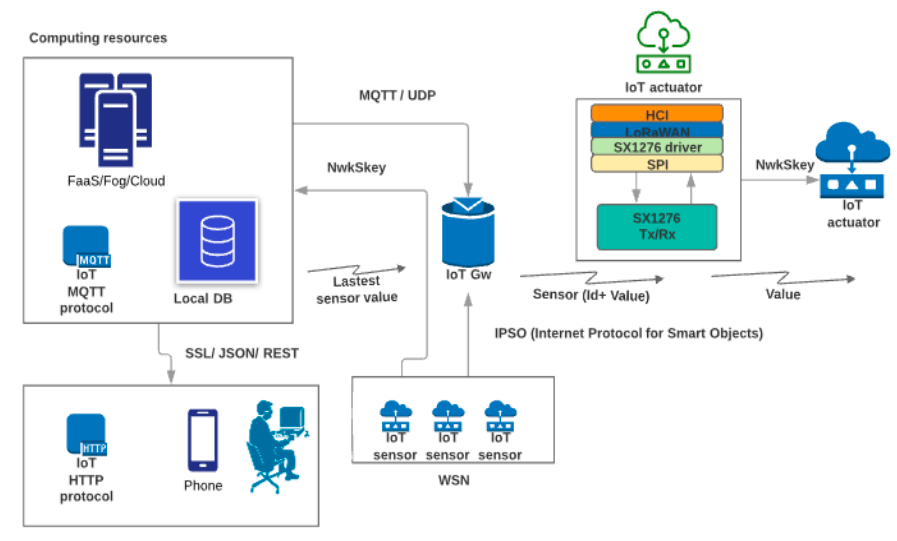
Figure 12. Technological components of an IoT ecosystem.